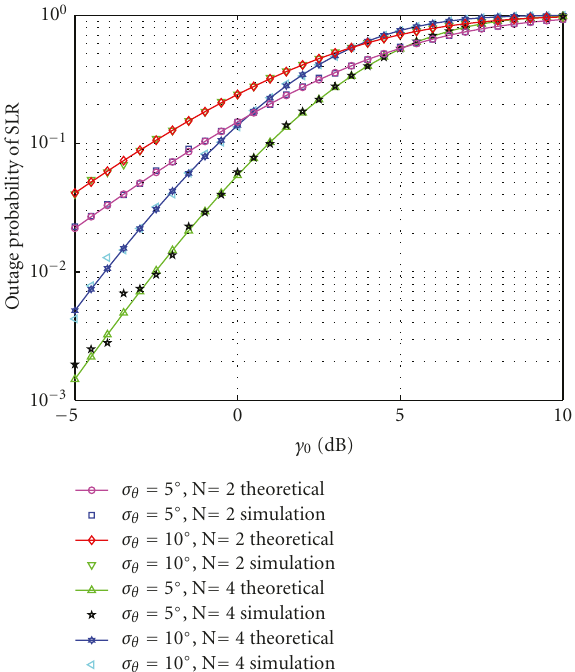
Figure 7: Comparison of theoretical and simulated outage proba- bility as a function of γ 0 for user i = 1 ( w i is obtained from (32) and Gaussian AoA model is